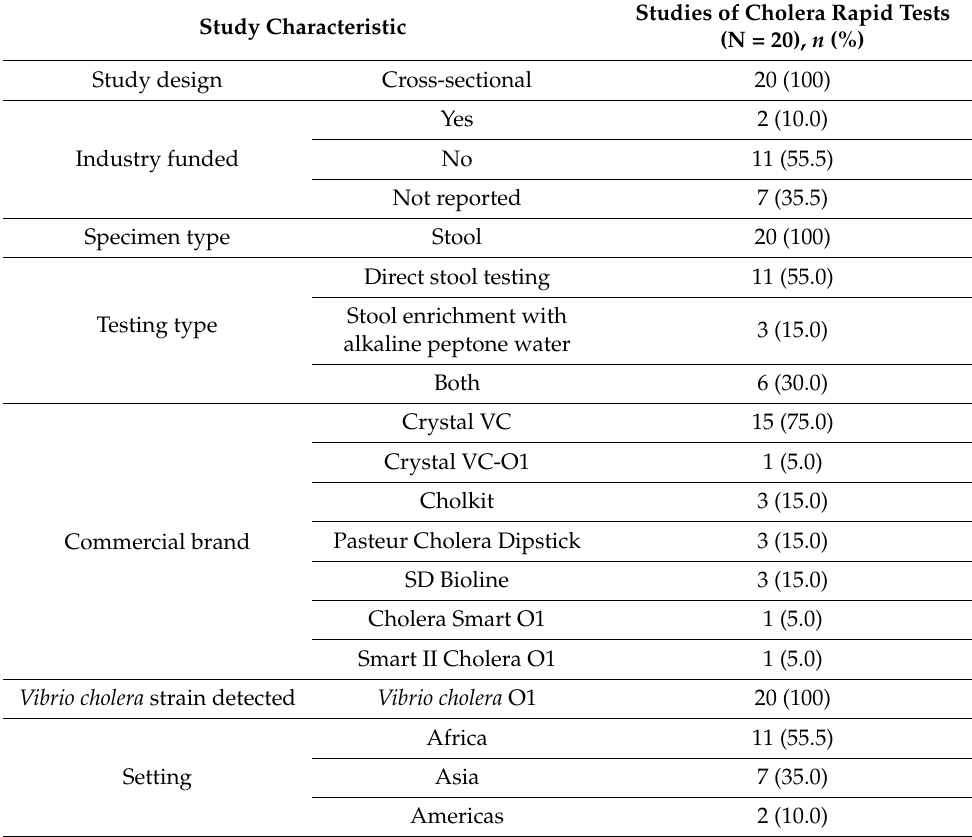
Table 1. Characteristics of included